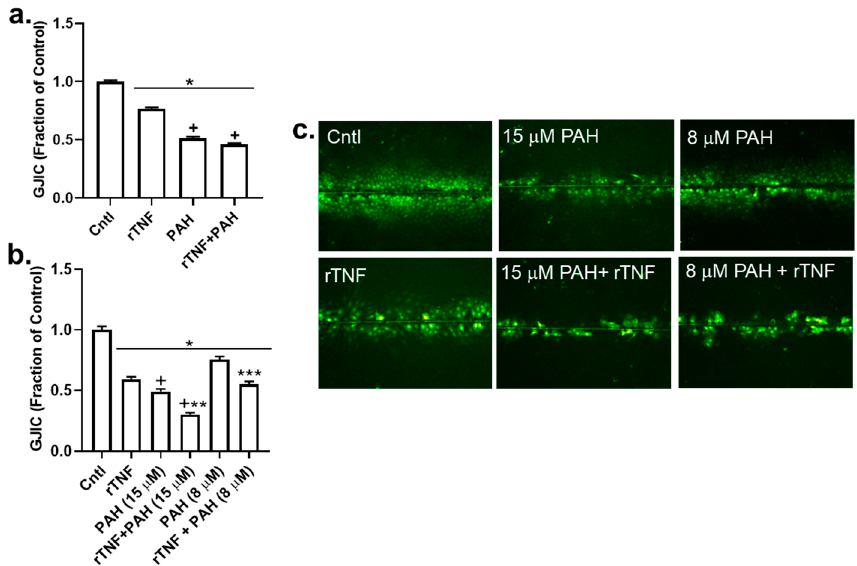
Figure 9. rTNF-induced dysfunction of GJIC was further enhanced in the presence of LMW PAHs. ( a ) A SL/DT assay was used to measure GJIC 4 h following treatment with rTNF (1 ng/mL), LMW PAH mixture (40 µ M; 1:1 ratio of 1-methylanthracene and fluoranthene), or combinations of both rTNF and PAH mixture. * p < 0.05 treatment at both time points compared to control; + p < 0.05 for PAH or rTNF plus PAH (40 µ M) treatment. ( b ) A SL/DT assay was used to measure GJIC 24 h following treatment with rTNF (1 ng/mL), LMW PAH mixture (8 or 15 µ M; 1:1 ratio of 1-methylanthracene and fluoranthene), or combinations of both rTNF at either the low (8 µ M) or high (15 µ M) dose of LMW PAHs. * p < 0.05 treatment at both time points compared to control; + p < 0.05 rTNF treatment at 24 h compared to PAH or the combination of PAH plus rTNF at 4 h; *** p < 0.05 PAH plus rTNF (8 µ M) at 24 h treatment compared to rTNF or PAH (8 µ M) at 24 h. Experiments repeated 3 times with an n = 3 per treatment per experiment. ( c ) Representative images of the experiment depicted in ( b ). rTNF, recombinant TNF; PAH indicates the LMW PAH mixture described above. Magnification 100×.